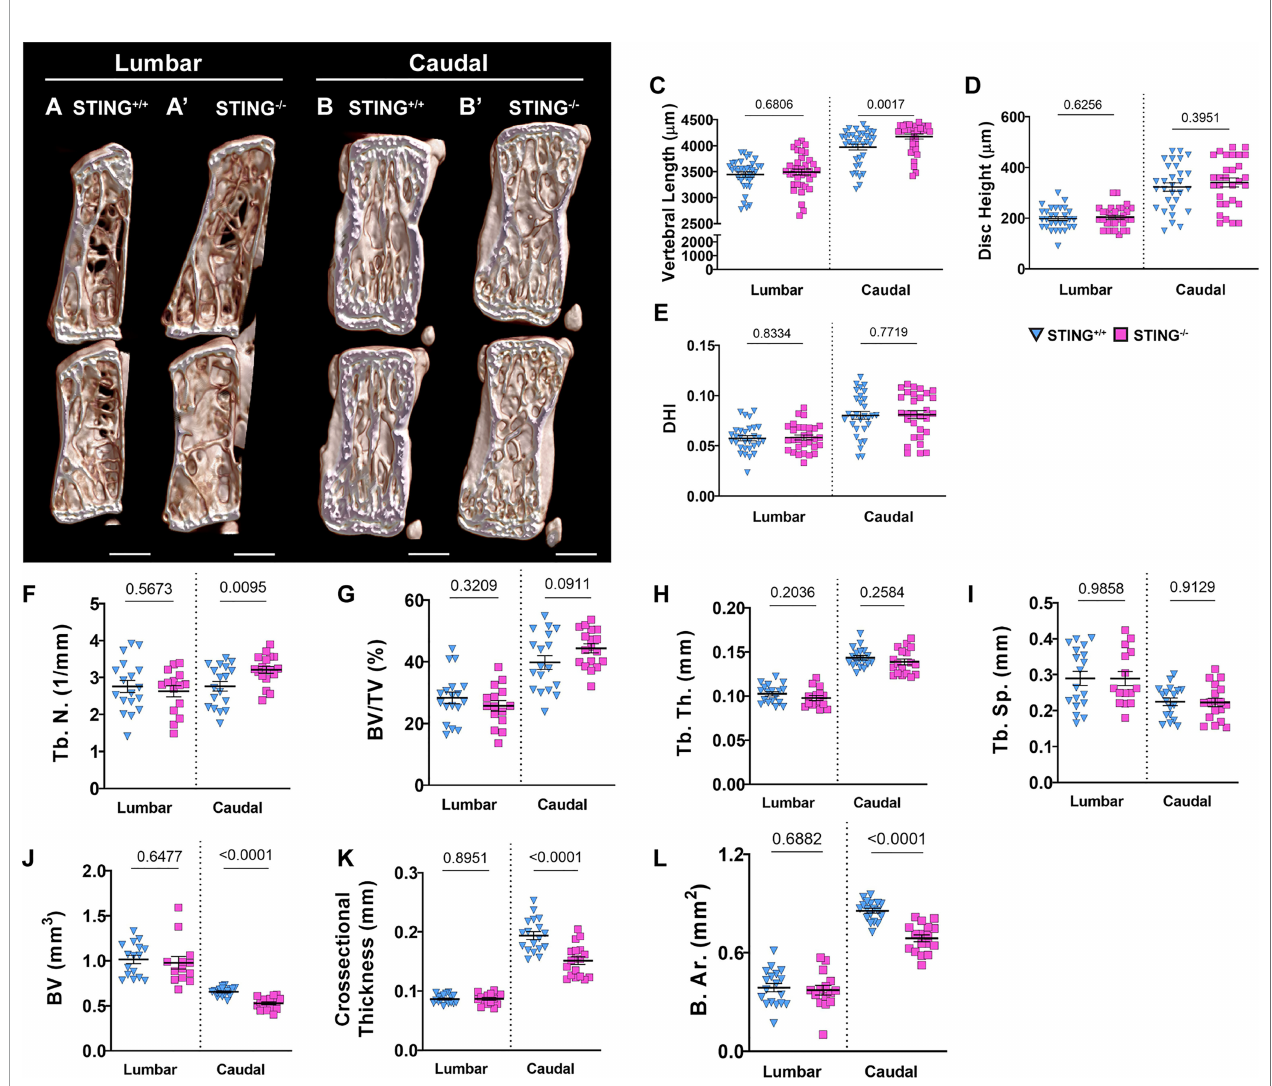
FIGURE 8 | Aged STING -/- mice show mild structural changes in the vertebral bone. (A, B ’ ) Representative m CT reconstructions of the hemi-section of a lumbar (A, A ’ ) and caudal (B, B ’ ) motion segment in a 16-18-month-old STING +/+ and STING -/- mouse. (C) Vertebral length, (D) disc height, (E) and disc height index (DHI) are shown for lumbar and caudal vertebrae. (F – I) Trabecular bone properties of (F) Tb. N. (trabecular number), (G) BV/TV, (H) Tb. Th. (trabecular thickness), and (I) Trab. Sp. (trabecular separation) are shown for lumbar and caudal vertebrae. (J – L) Cortical bone properties of (J) BV (bone volume), (K) Cs. Th. (cross-sectional thickness), and (K) B. Ar. (bone area) are shown. Quantitative measurements represent mean ± SD (n = 6 lumbar discs and 5 vertebrae/mouse, 6 mice/genotype; n = 6 caudal discs and 5 vertebrae/mouse, 6 mice/genotype). (A, B ’ ) Scale bar = 1mm. Signi fi cance was determined using an unpaired t-test or Mann-Whitney test, as